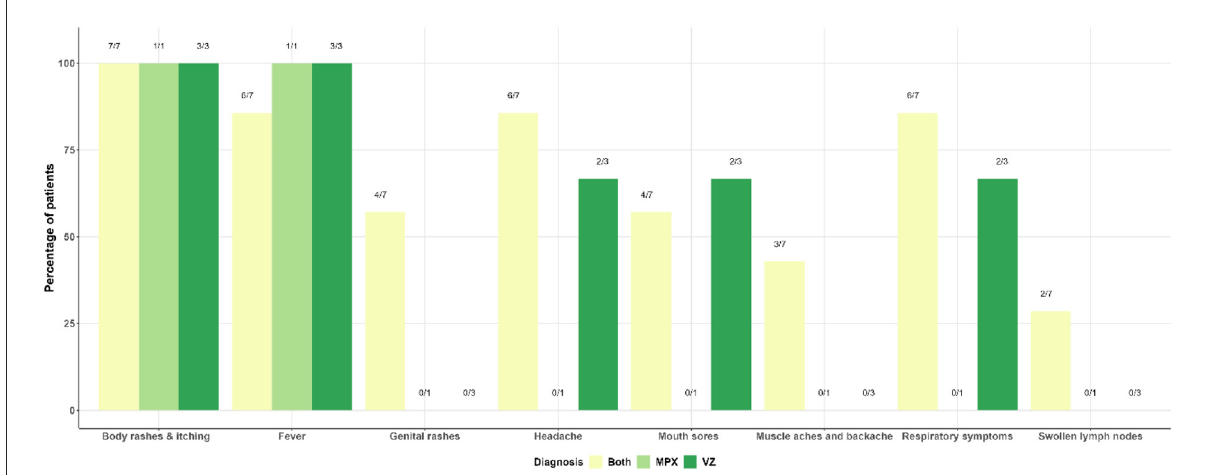
FIGURE5 Distribution of symptoms among patients diagnosed with MPX, VZ, and both.